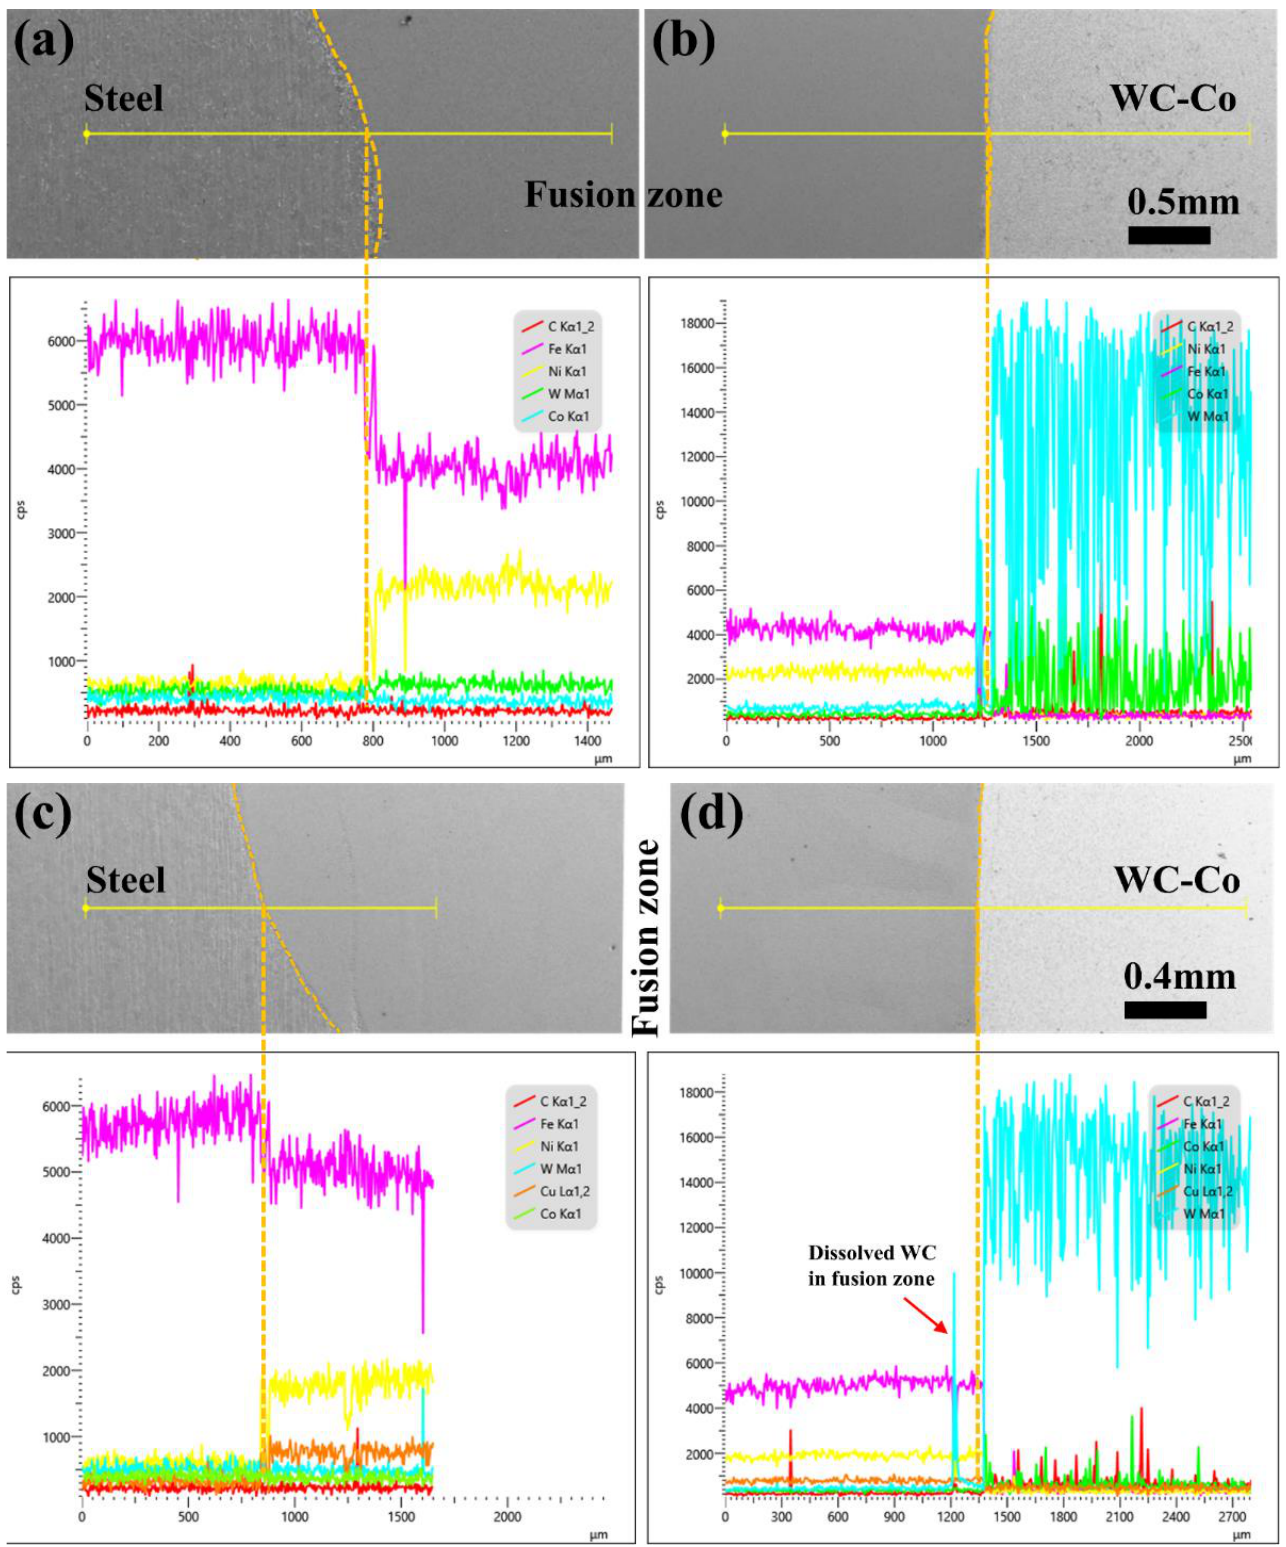
Figure 9. Line-scanning results for elements C, Fe, Co, Ni, and W diffusion near interface between WC-Co (right side) and steel (left side) with fusion zone in between in ( a , b ) specimen C 3 ; ( c , d ) specimen V 2 .